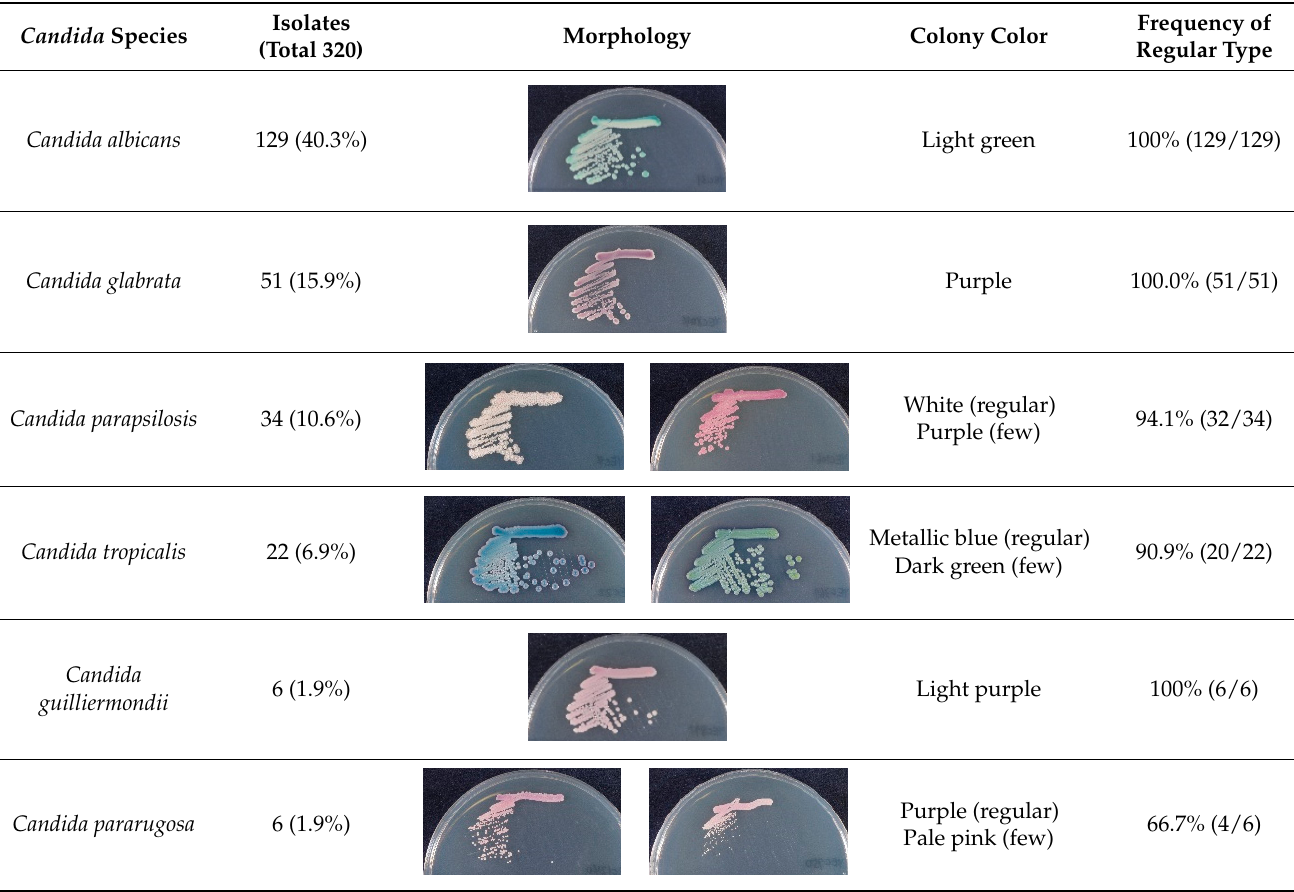
Table 4. Appearance of non- Candida species 1 in the oral samples on CHROMagar Candida plates.